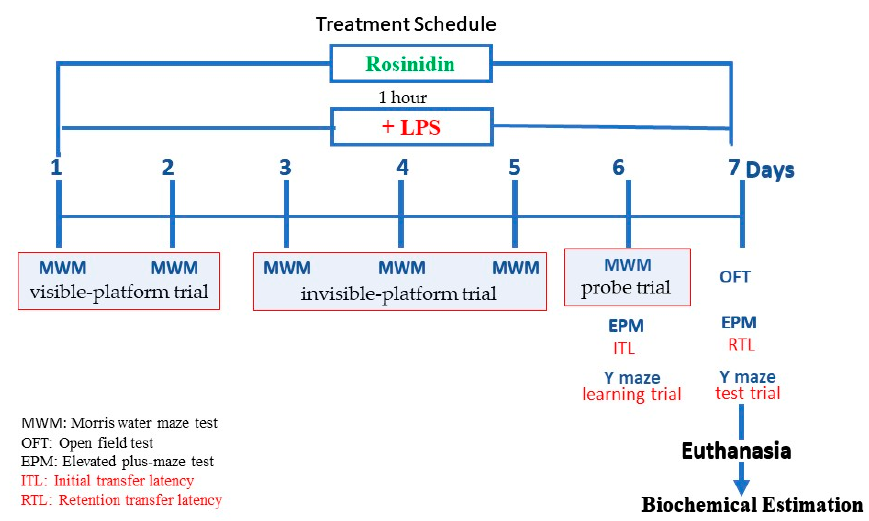
Figure 2. Schematic diagram of experimental protocol.